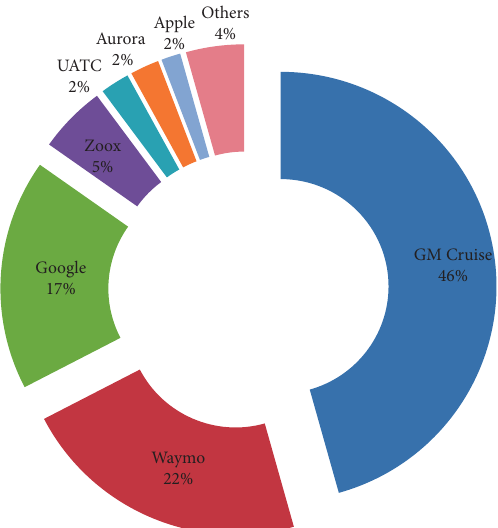
Figure 5: Breakdown of autonomous vehicle accident reports. (Data are statistically analyzed from the reports by the State